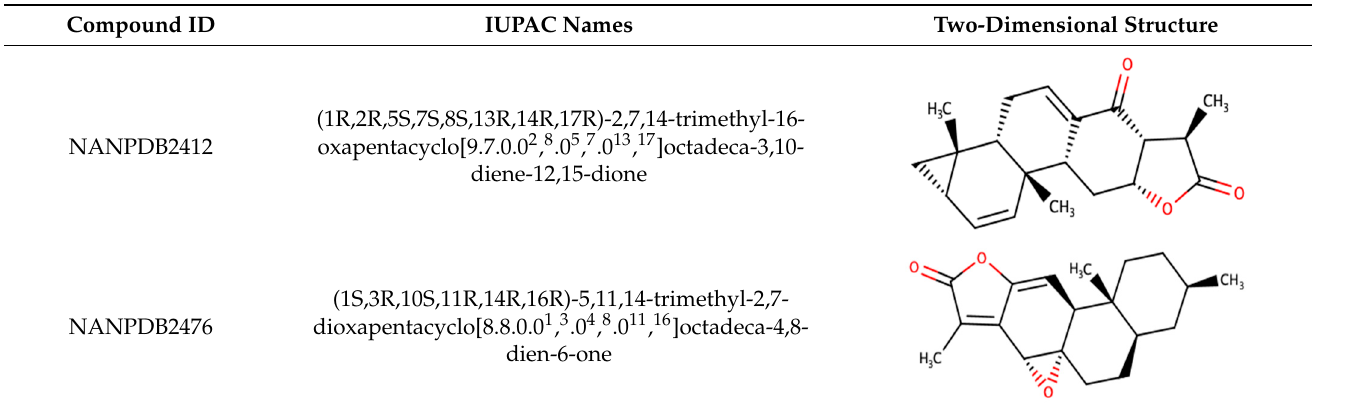
Figure 7. A plot of the binding free energy contribution per residue of EBOV VP35-NANPDB2476 complex derived from molecular mechanics Poisson-Boltzmann surface area (MM-PBSA) analysis. The critical residues contributing to the binding energies are shown in red.